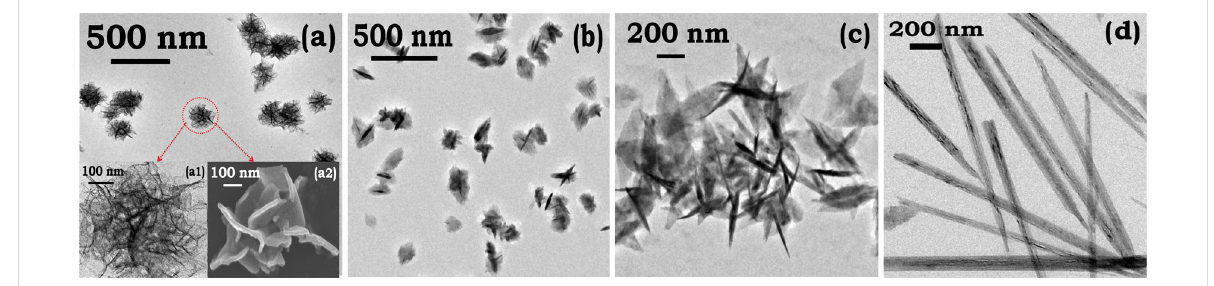
Figure 1: The concentration of TMAH and the growth temperature play a critical role in controlling the morphology of cobalt nanoplates. FEGTEM micrographs captured after 45 min: (a) Sample A ( c TMAH = 0.01 M) size of single flower = 250 nm, insets (a1) and (a2) show flower-like structures made of cross-linked plates; (b) Sample B ( c TMAH = 1 M) nanoplate diameter = 200 nm, thickness = 25 nm; (c) Sample C ( c TMAH = 2.7 M) nanoplates with diameter = 250 nm, thickness = 30 nm; (d) nanorods obtained at 50 °C with length = 1400 nm and diameter = 110